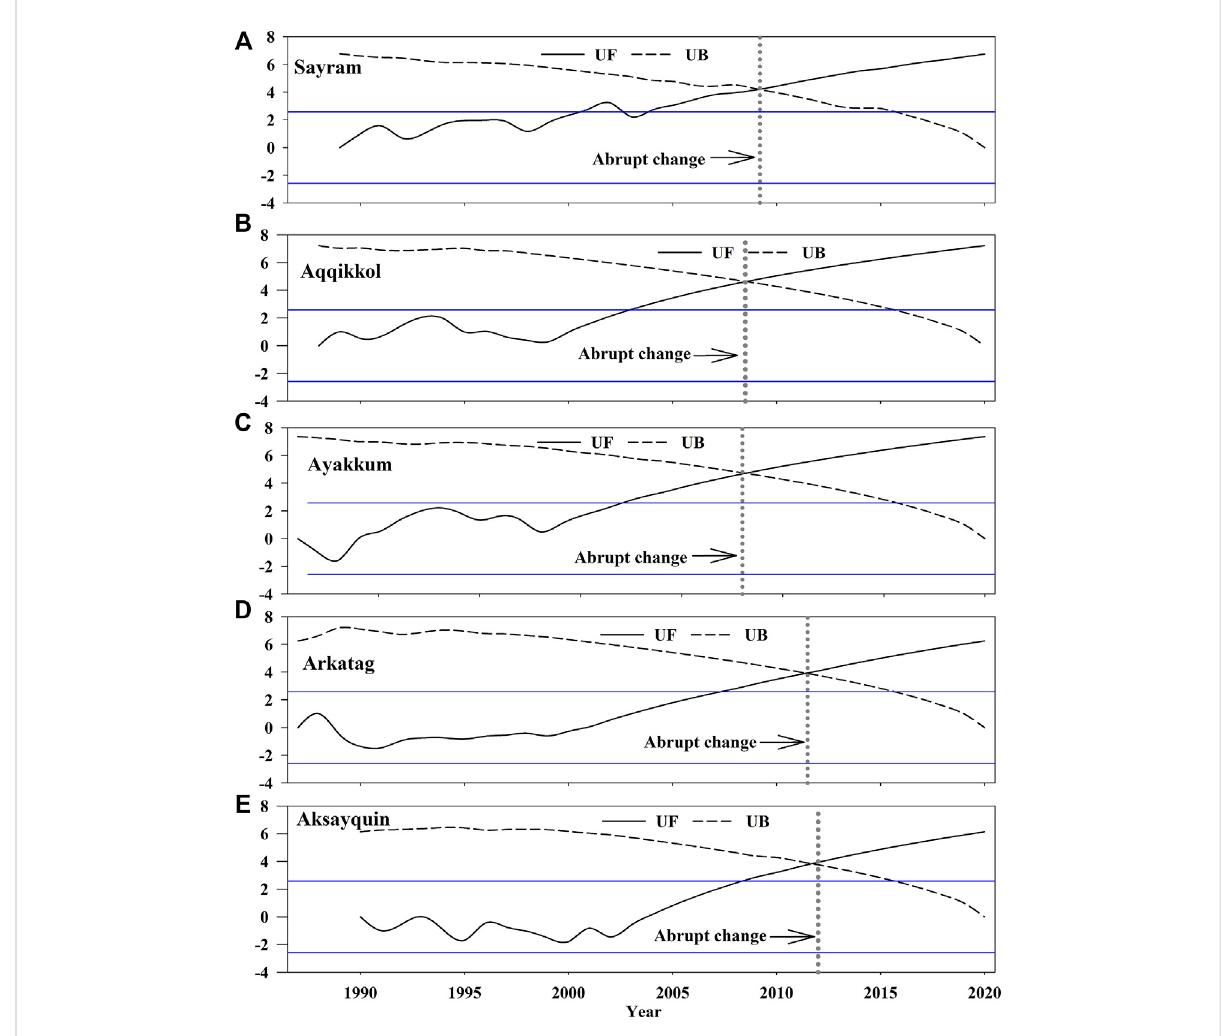
FIGURE 7 Results of the abrupt-change test of typical mountain lake areas in Xinjiang from 1986 to 2020 (A) Lake Sayram; (B) Lake Aqqikkol; (C) Lake Ayakkum; (D) , Lake Arkatag; (E) Lake